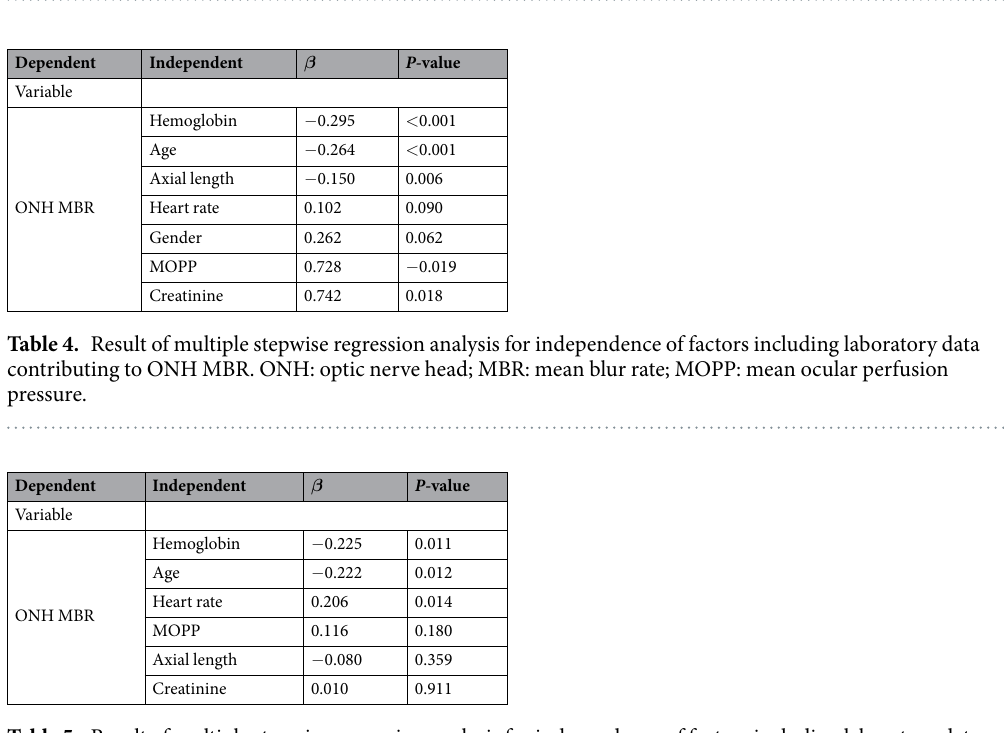
Table 5. Result of multiple stepwise regression analysis for independence of factors including laboratory data contributing to ONH MBR in the male group. ONH: optic nerve head; MBR: mean blur rate; MOPP: mean ocular perfusion pressure.